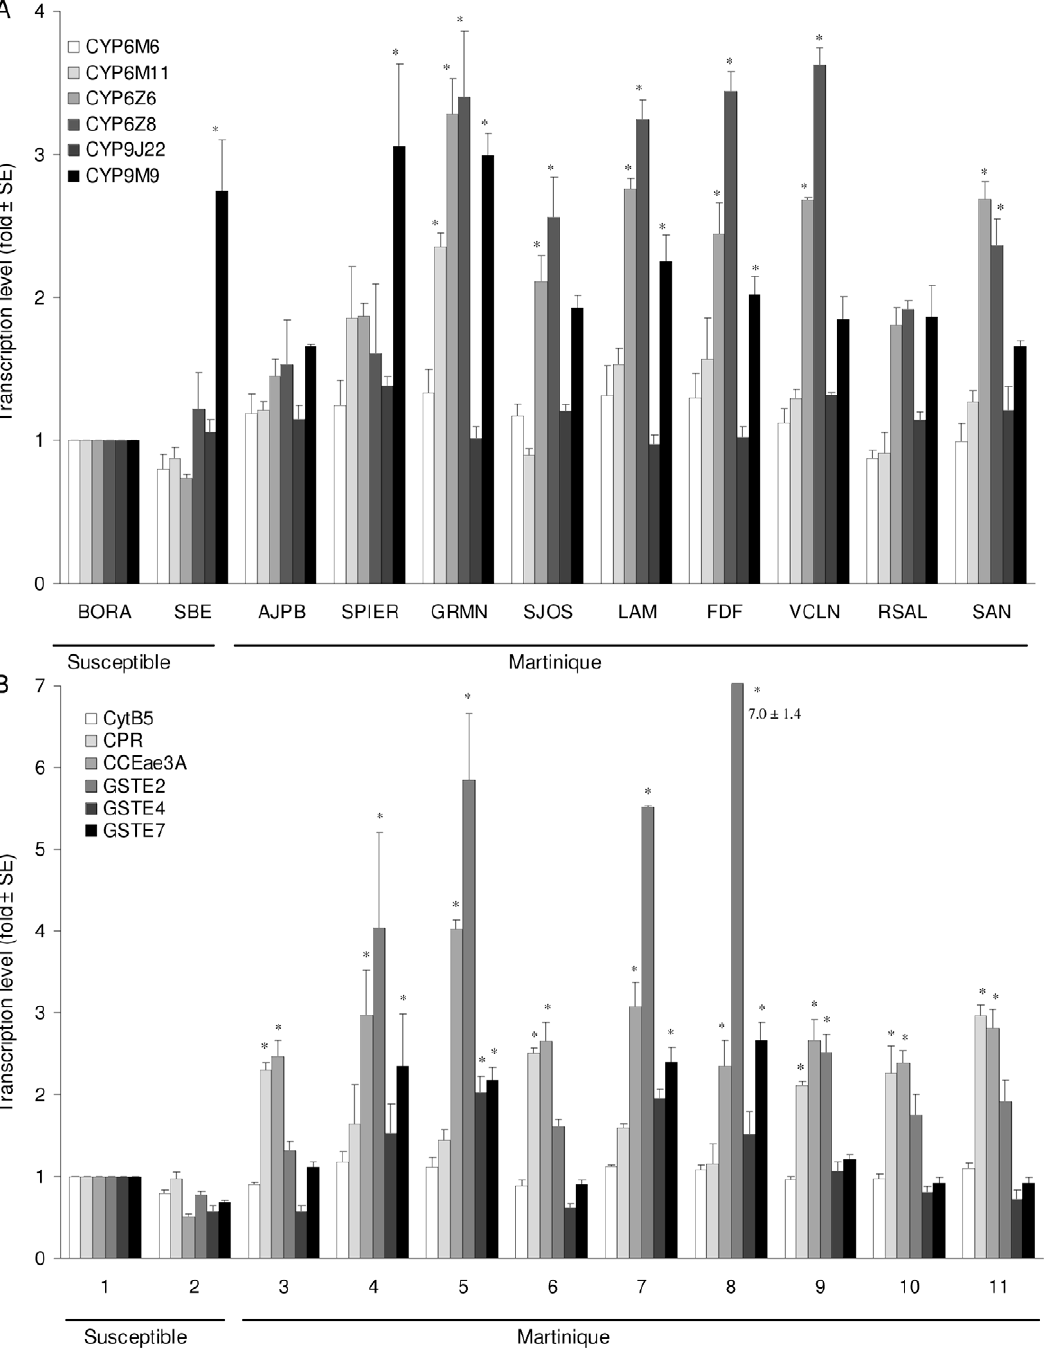
Figure 2. Larval transcription levels of (A) 6 cytochrome-P450-monooxygenases and (B) 2 P450-cofactors, 3 GST and 1 CCE genes estimated in the populations of Martinique and the susceptible SBE strain relative to the susceptible Bora-Bora strain. Transcription ratios obtained from real-time quantitative RT-PCR were normalized with the 2 housekeeping genes AeRPL8 and AeRPS7 and shown as mean value ( 6 SD) over 3 independent biological replicates. Genes significantly over-transcribed (transcription ratio . 2-fold and P value , 0.05) are indicated by stars.